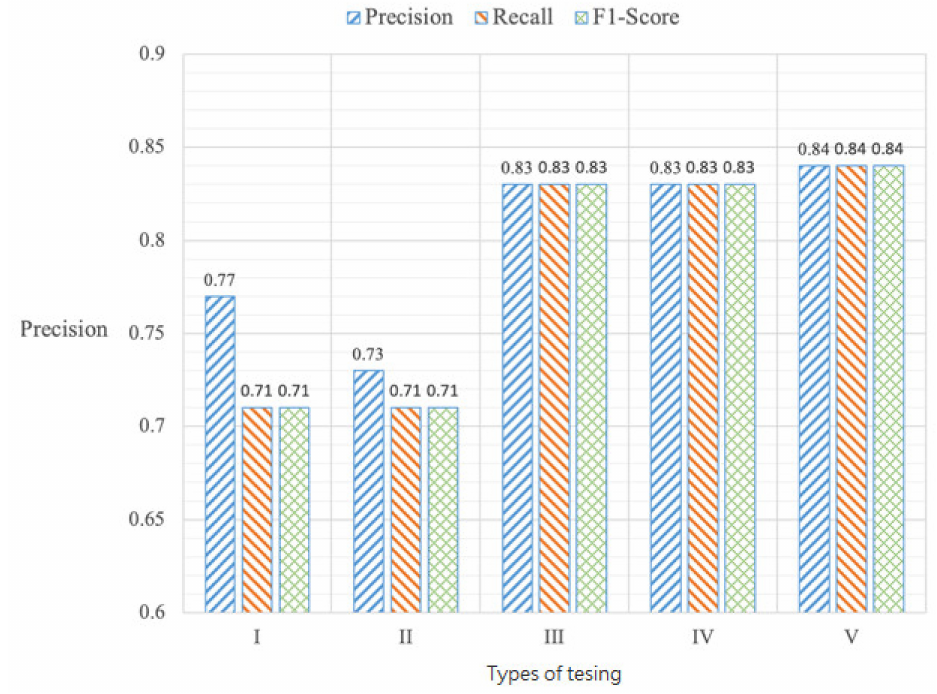
Figure 17. The impact of header features on classification